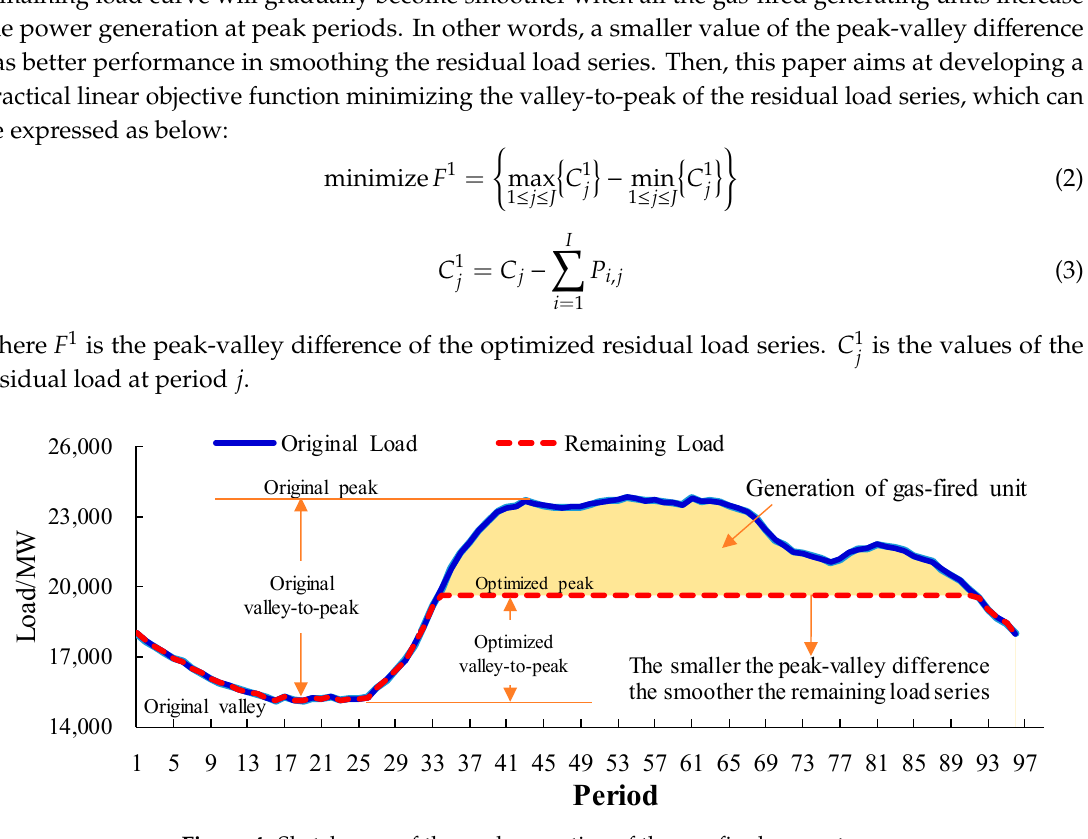
Figure 4. Sketch map of the peak operation of the gas-fired generators.